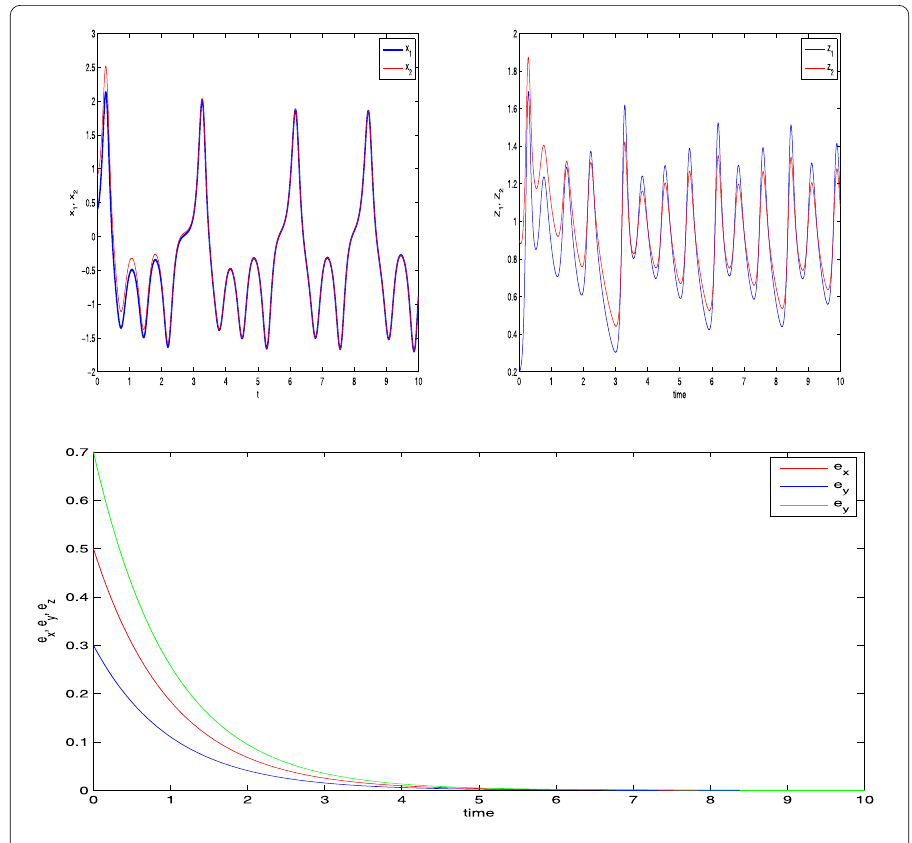
Figure 7 Time domain response for x 1 , x 2 , z 1 , z 2 and the error functions e x , e y and e z for both systems when α 1 = α 2 = α 3 = 1 and δ = 5, γ = 0.5, R =